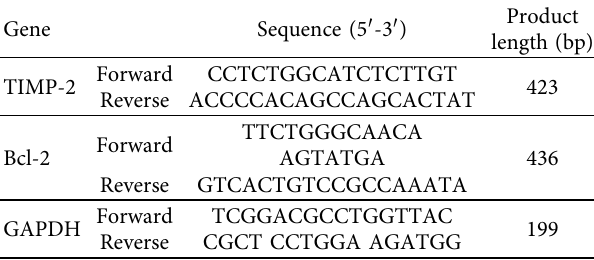
Table 1: Specific primer sequences for RT-qPCR.